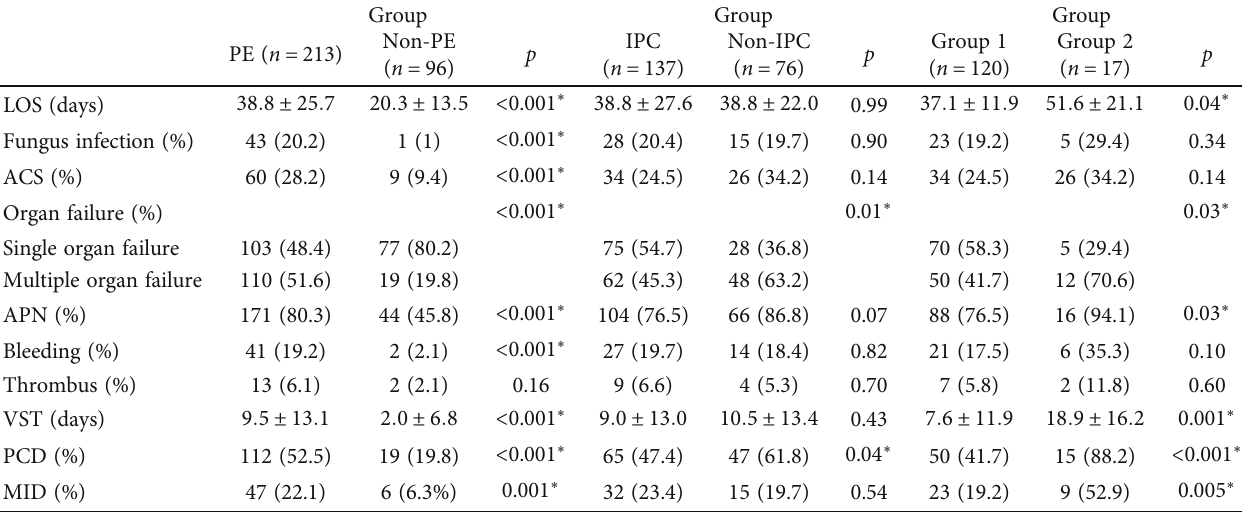
Table 4: Primary and secondary endpoints of PE and non-PE groups, IPC and non-IPC groups, and group 1 and group 2. Group Group Group PE ( n = 213 )